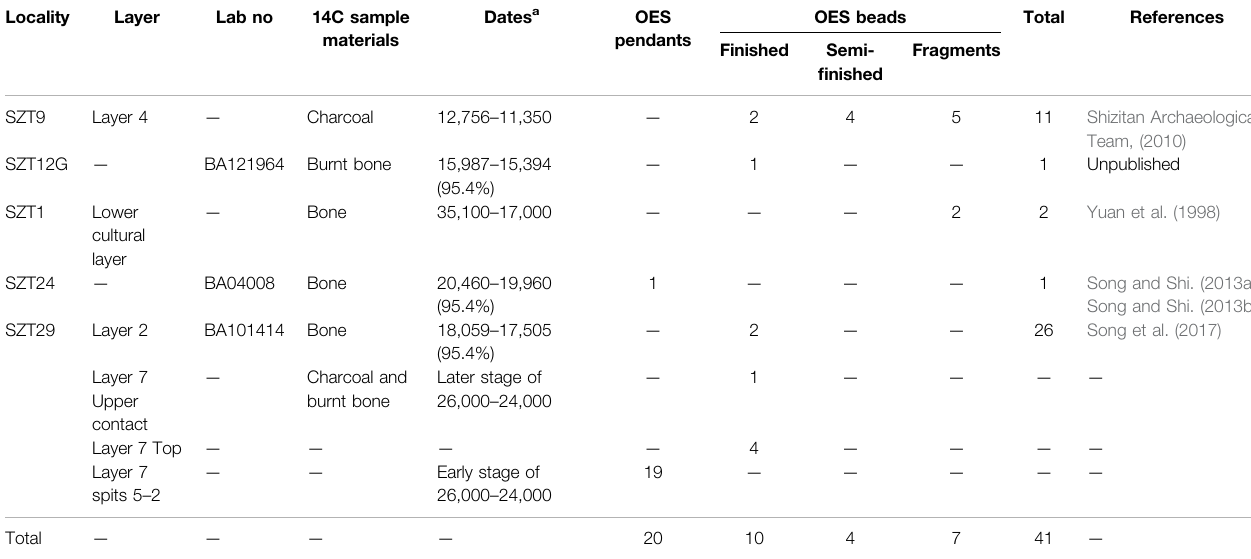
TABLE 1 | OES ornament counts, contexts, and associated radiocarbon dating at Shizitan localities.